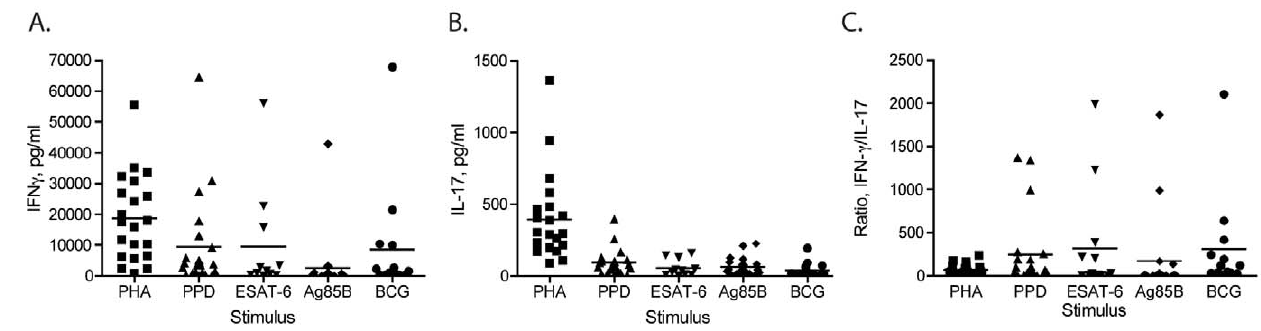
Figure 1. Variation of IFN- c and IL-17 responses to mycobacterial antigens. PBMC were incubated with the indicated stimuli for 24 h (for IFN- c responses) or 72 h (for IL-17 responses); cytokine secretion was assayed by ELISA. (A) IFN- c secretion in response to PHA, PPD, ESAT-6, Ag85B, or live M. bovis BCG. Each symbol reflects responses of a single subject whose responses were assayed in triplicate. The horizontal bar indicates the mean value for the group. (B) IL-17 secretion in response to PHA, PPD, ESAT-6, Ag85B, or live M. bovis BCG. Each symbol reflects responses of a single subject whose responses were assayed in triplicate. The horizontal bar indicates the mean value for the group. (C) Ratio of IFN- c to IL-17 secretion in response to the stimuli in panels A and B. Ratios were calculated using the mean value for IFN- c and for IL-17 for each subject; the horizontal bar indicates the mean value for the group of subjects.